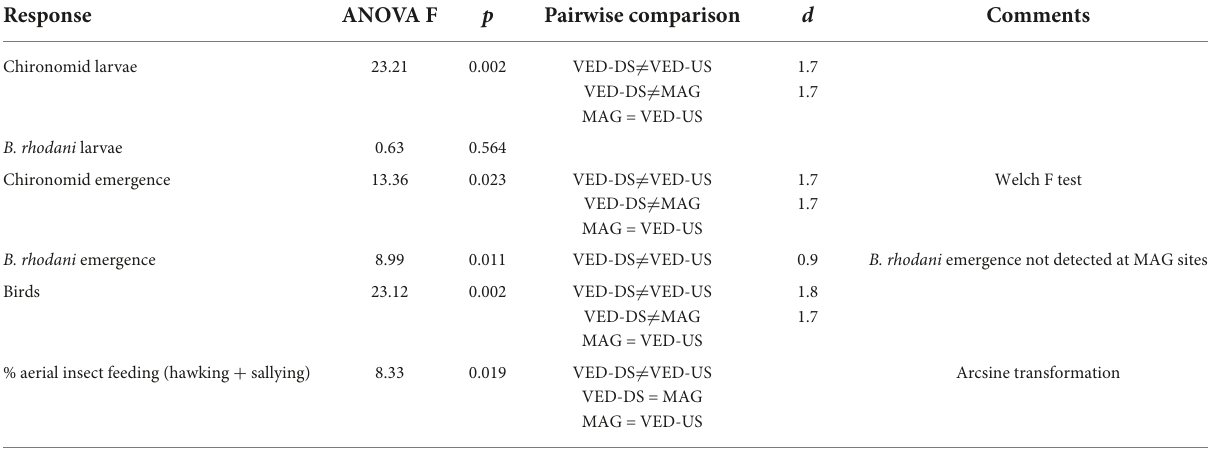
TABLE 3 Results of ANOVA tests and Tukey’s pairwise comparisons (with effect sizes, d